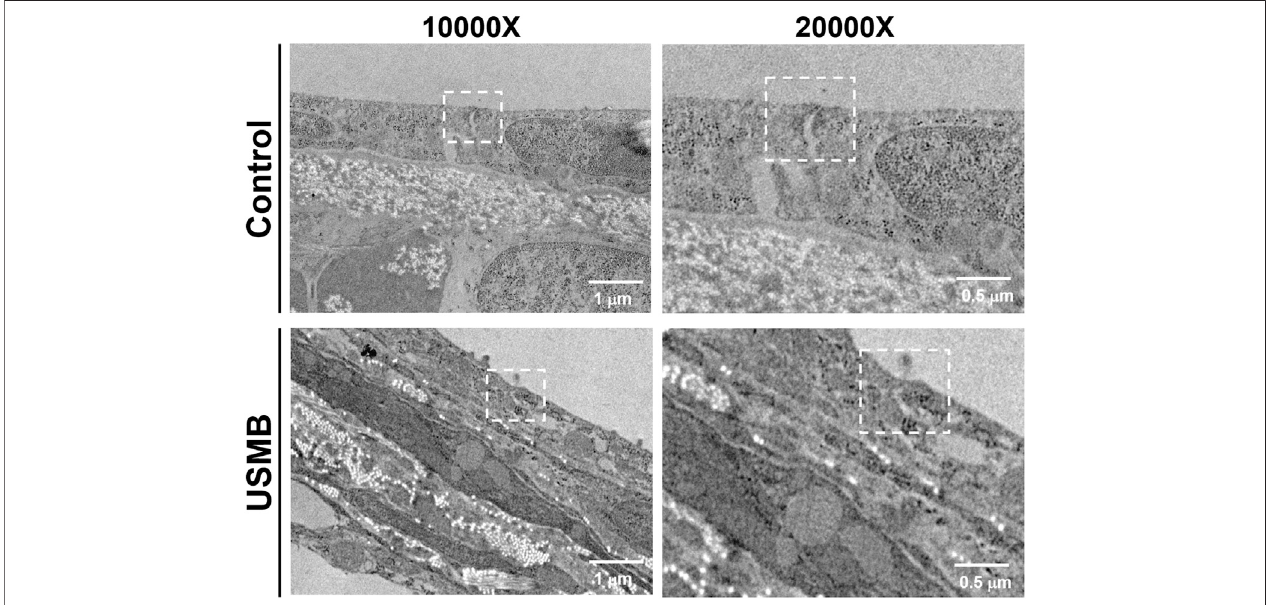
FIGURE11 | Transmission electron micrographs ofthe TJ region in the outer epithelium ofthe RWM with (lowerpanels) or without prior USMB exposure (upper panels) . Cell membranes of adjacent cells in close apposition in a TJ of the control group exhibited more signi fi cant accumulation of perijunctional actin protein complexes(whitesquares).ThisproteincomplexwasabsentintheTJregionofadjacentcellsafterUSMBtreatment.USMB,groupreceivingtheultrasoundmicrobubble treatment; Control, mouse group treated with microbubbles but without ultrasound